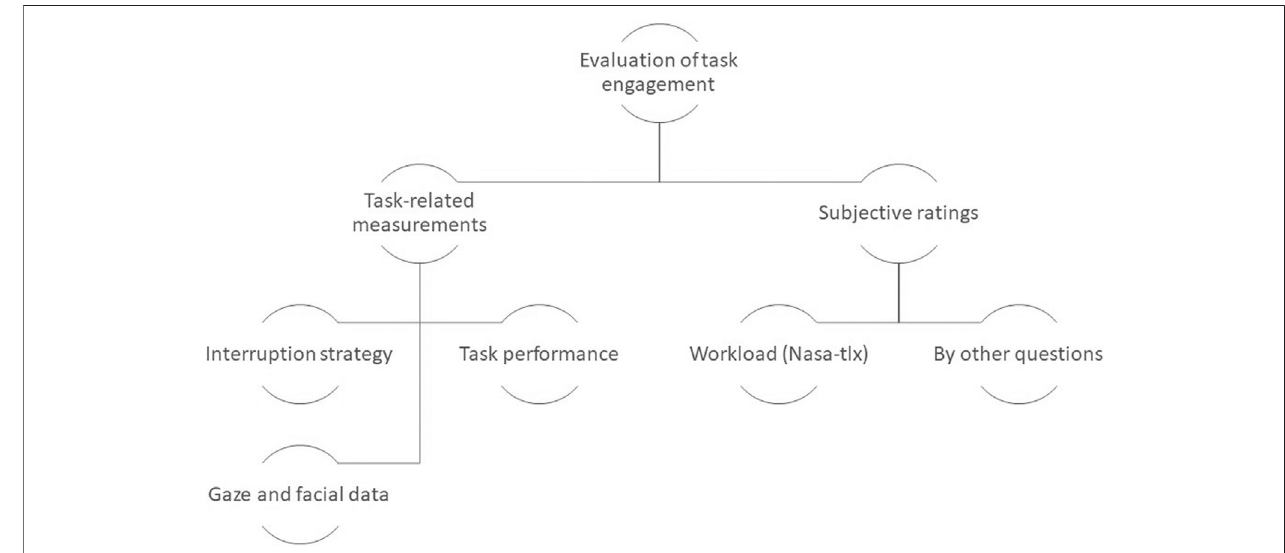
FIGURE 2 | Illustration of task engagement measurements in the selected